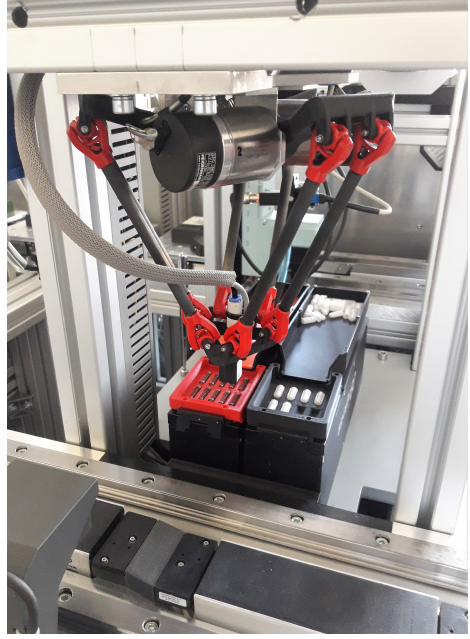
Figure 1. Delta robot as a part of the smart factory.